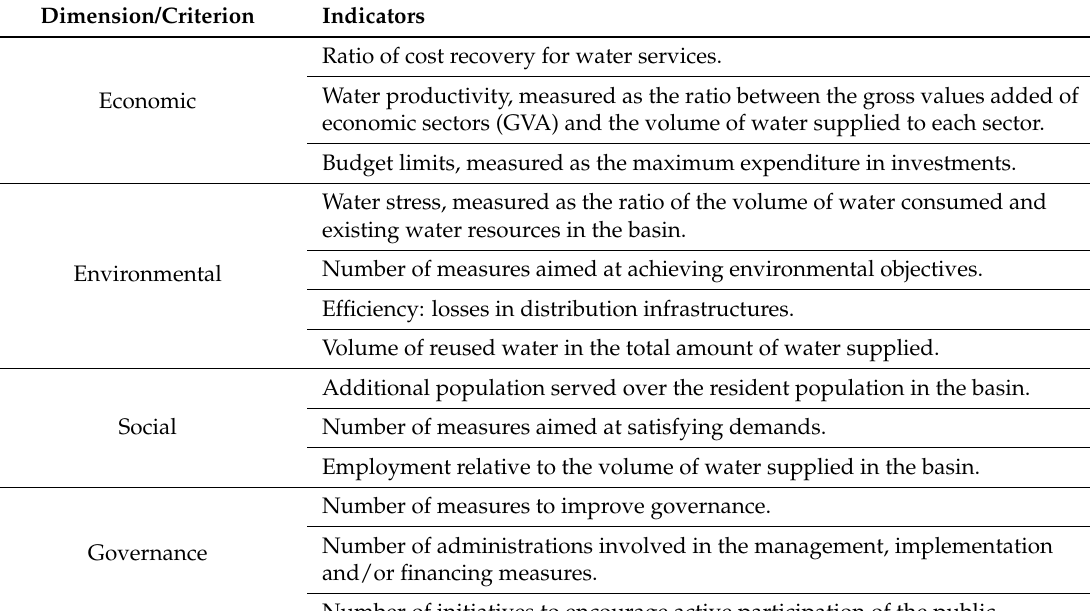
Table 2. Dimensions and indicators to assess the sustainability of